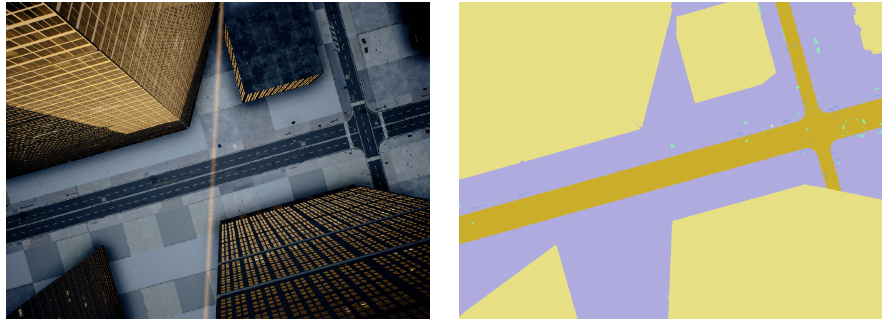
Figure 4. High-altitude urban scene captured with a downward-looking camera. On the left is a simulated image. On the right is the corresponding segmented scene.